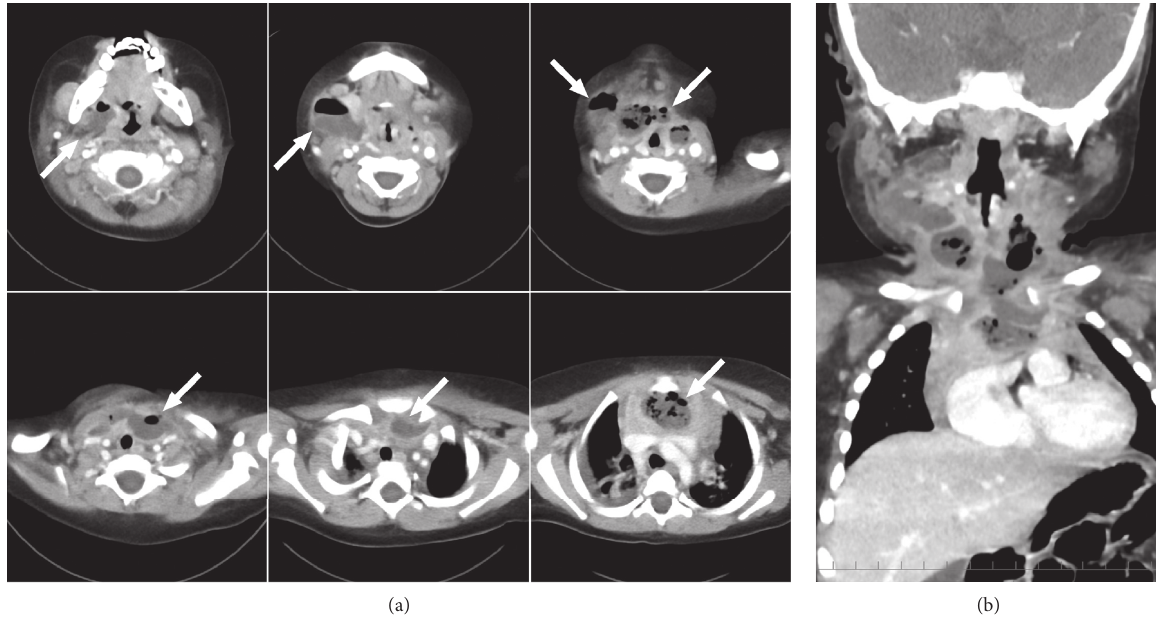
Figure 1: Axial (a) and coronal (b) images from the contrast-enhanced CTscan of the head and chest on admission. The white arrows show an abscess ranging from the neck to the anterior mediastinum.